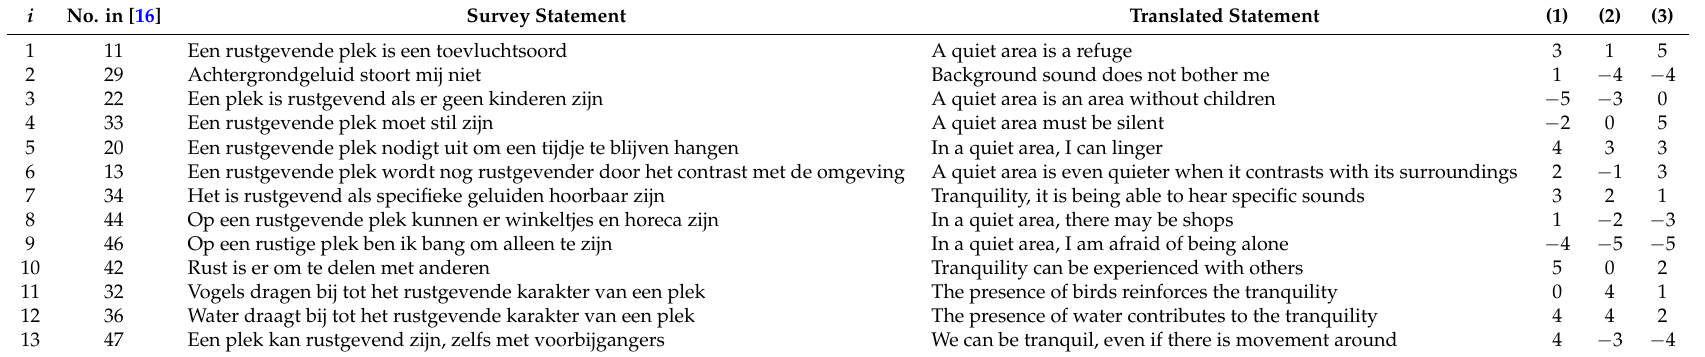
Table 1. Tranquility statements used in the Antwerp parks survey campaign with their corresponding reference number to the French quiet areas study [16]. Prototypical group markings ( g ki ) are provided for each statement i and three tranquility groups k : ( 1 ) —“Social relationships” group, ( 2 ) —“Natural sound sources” group, ( 3 ) —“Silence”